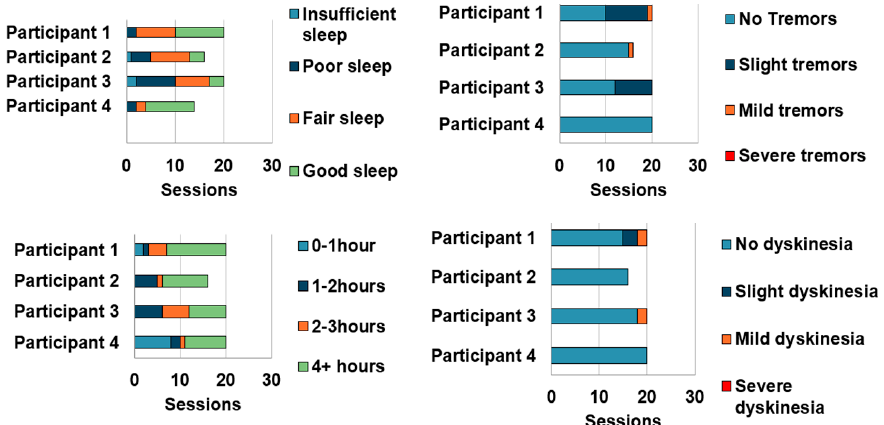
Figure 13. Bar graph representing self-reported measures obtained through daily questionnaire (top-left) sleep quality, (top-right) tremor symptom, (bottom-left) medication intake time, and (bottom-right) dyskinesia symptom.